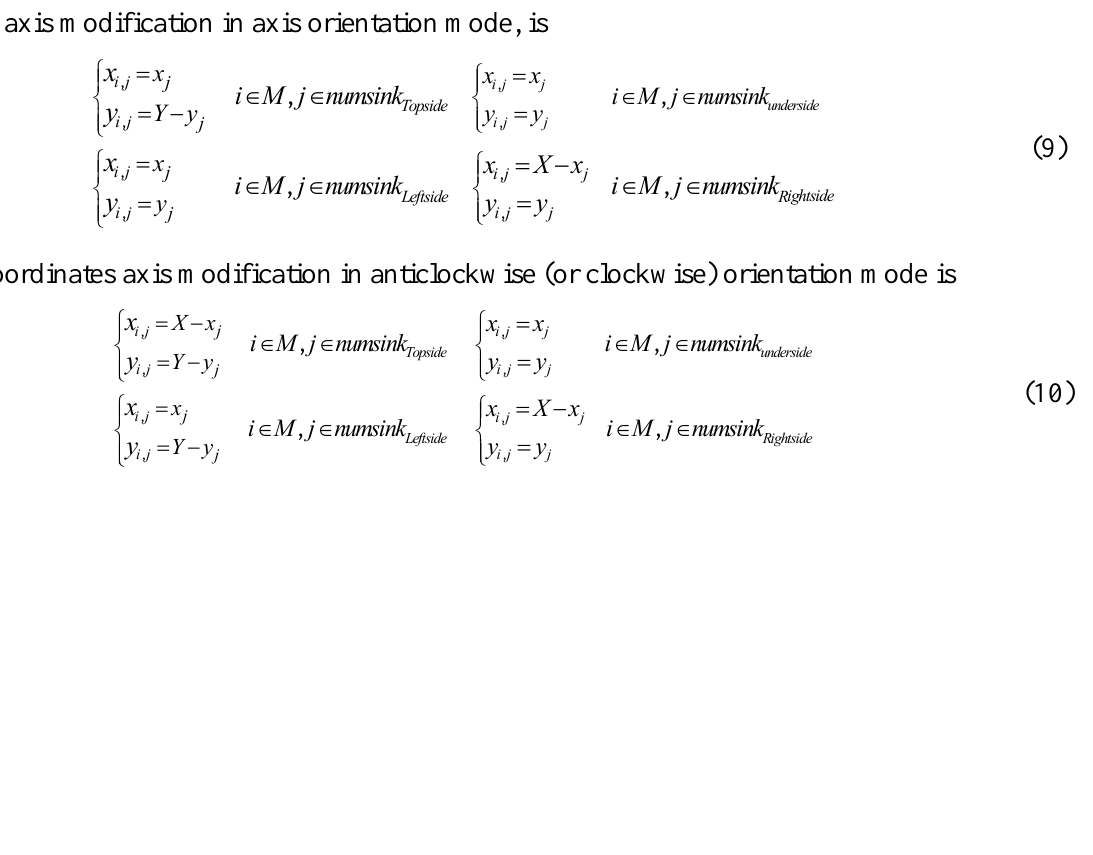
(b) Anticlockwise (or